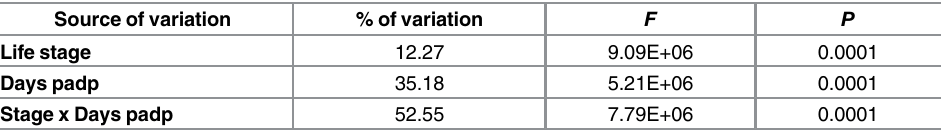
Table 5. ANOVA on the effects of life stage during the acquisition access period (nymphs vs. adults), days post-first access to diseased plants (padp) and their interaction on Las titer in D . citri (relative to RPS20 psyllid